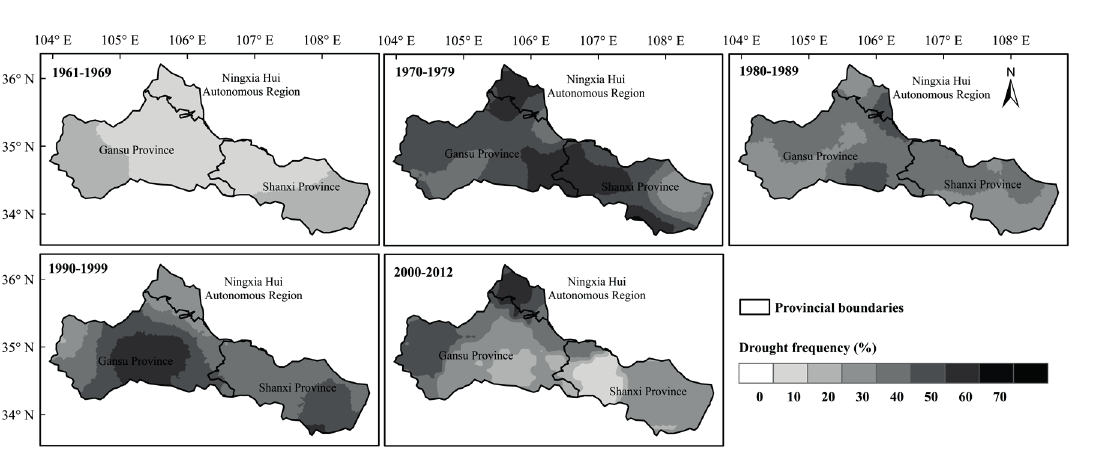
Fig. 4 Decadal drought frequency map of the Weihe River basin, based on gridded